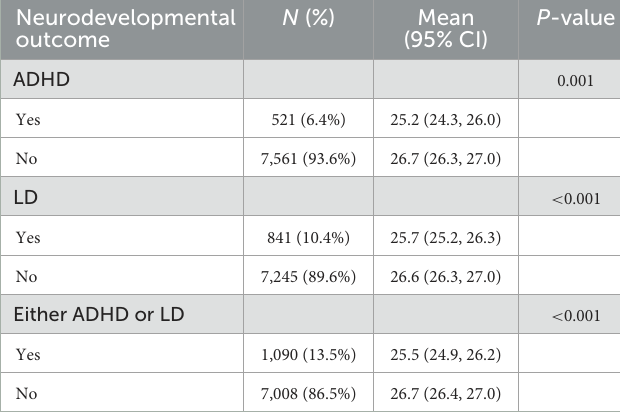
TABLE 1 Characteristics of maternal age of children included in the study (NHANES 1999–2004; n = 8,098).